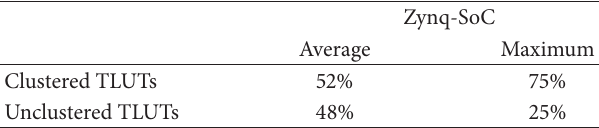
Table 2: TLUTs cluster rate of a 64-tap FIR filter in a single CLB column.